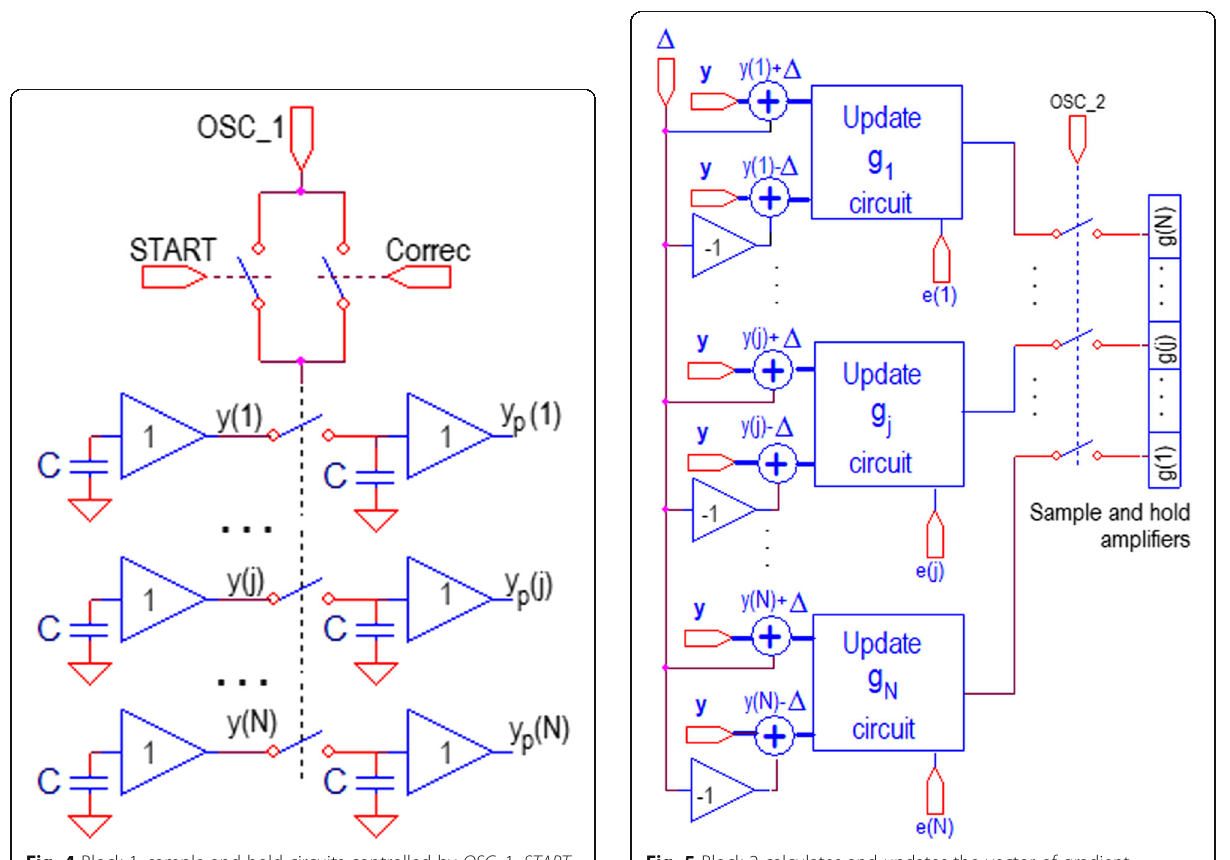
Fig. 5 Block 2 calculates and updates the vector of gradient samples